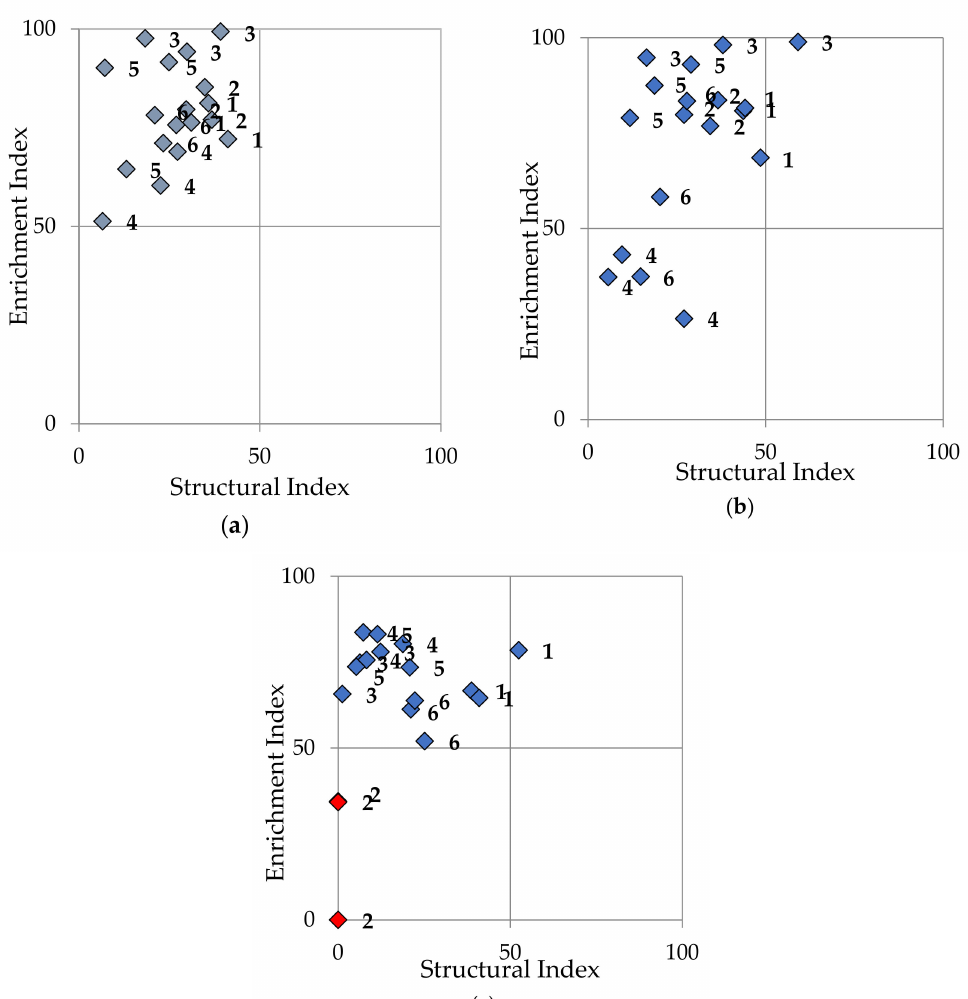
Figure 3. Soil trophic webs in variants (( a )—Untreated; ( b )—Treated with conventional nematicide; ( c )—Treated with DMDS) during whole study period (Sampling: 1—1 DBA; 2—18 DAA; 3—104 DAA at the end of Crop 1; 4—258 DAA after winter period, at the end of crop 3; —362 DAA at the end of crop 4, 6—450 DAA, at the end of crop